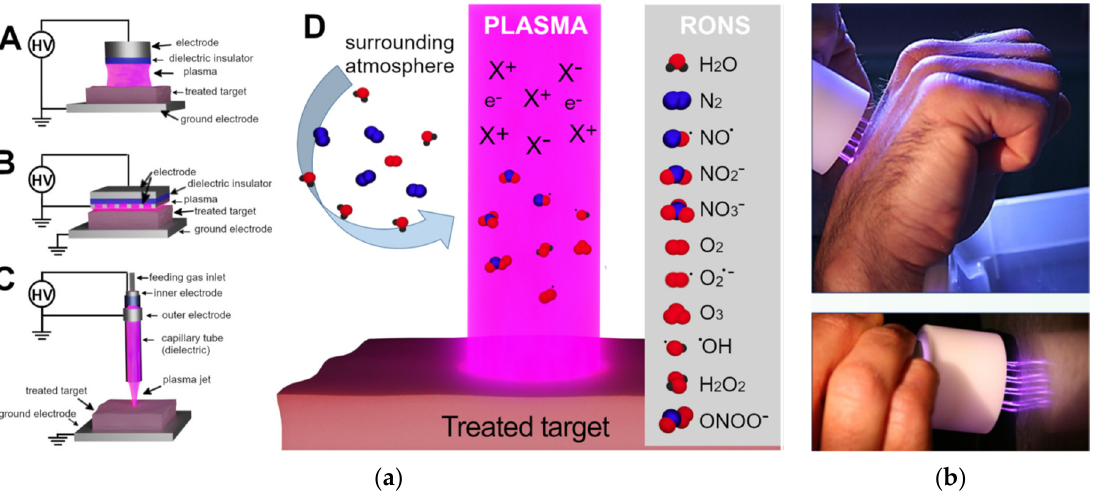
Figure 1. ( a ) Typical configurations of non-thermal atmospheric plasma sources facing a target comprise floating-electrode DBD (A), DBD surface plasma (B), and APPJ source (C). Schematic of an APPJ column (D) together with the generated charged species, and reactive oxygen and nitrogen species or RONS. Reproduced from [14]. Published by Elsevier under the Creative Commons CC-BY-NC-ND license. ( b ) Images of a plasma multi-jet source aimed at skin treatment. Reprinted/adapted with permission from Ref. [15]. Copyright 2017, Elsevier GmbH.